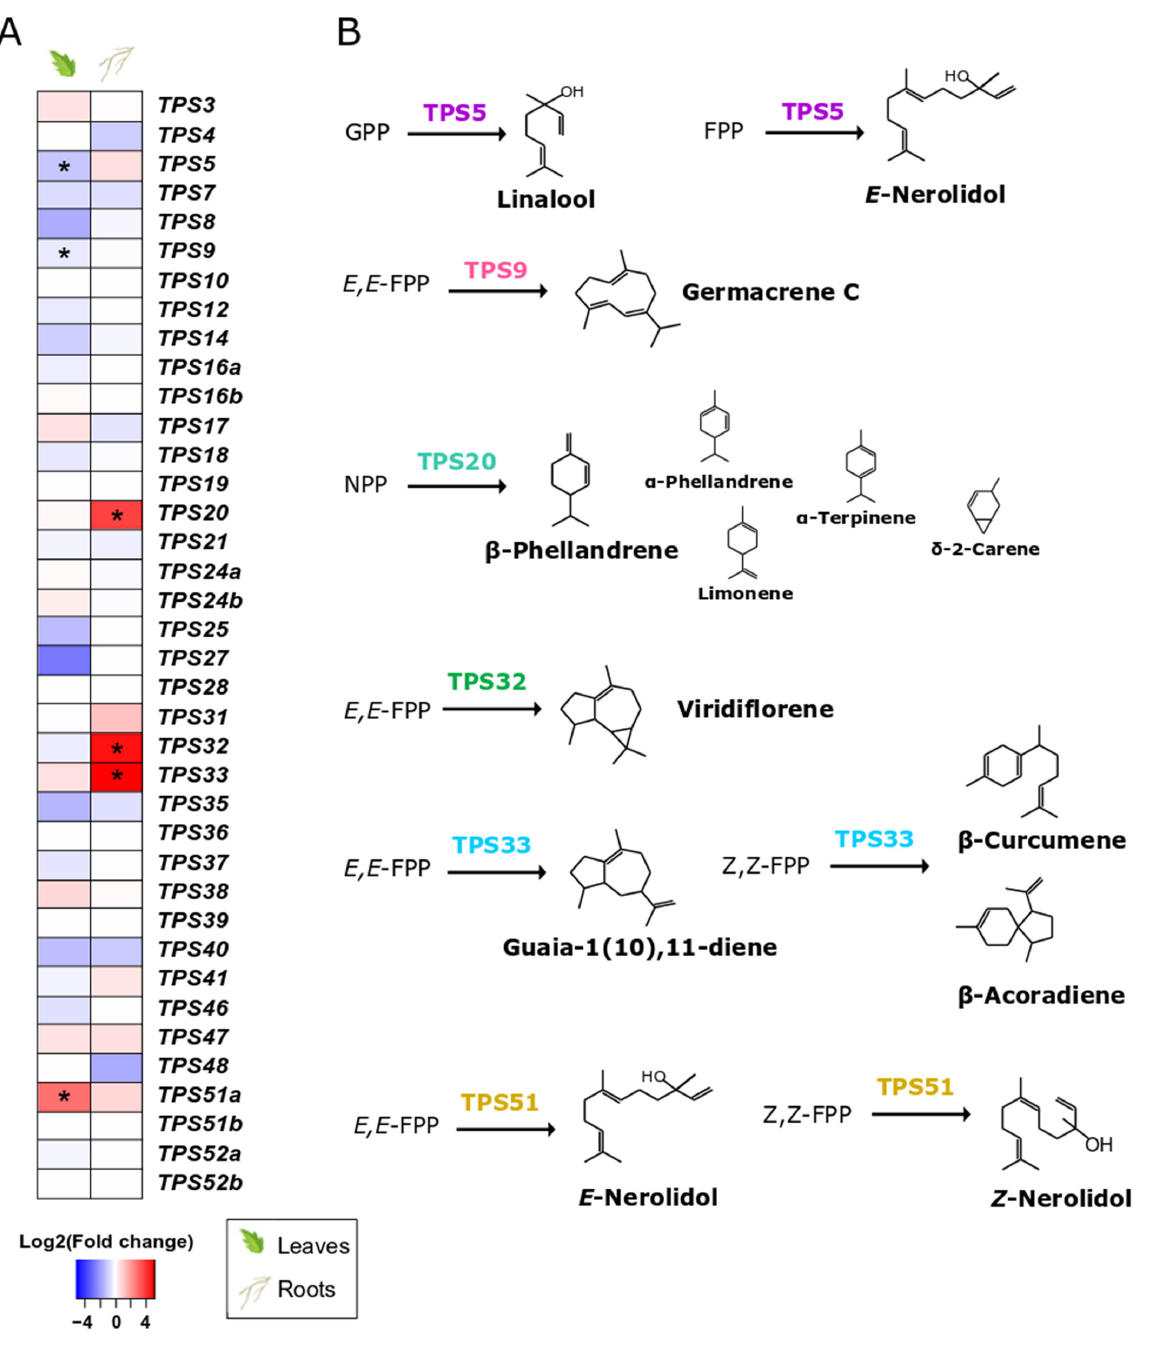
Figure 5. The tomato TPS family. ( A ). Effect of S. indica colonisation on the expression of tomato TPS s in leaves and roots. Changes in gene expression between tissues from inoculated plants and tissues from endophyte-free plants are represented as log2 of the fold change in the form of a heatmap. Data derived from RNA sequencing on leaves and roots from S. indica - and mock-inoculated plants. Asterisks (*) indicate FDR-corrected p ≤ 0.05, apart from TPS32 and TPS33 , whichwere expressed only in samples from inoculated roots, and no related transcripts were found in the samples of control roots. ( B ). Biosynthetic pathways catalysed by the TPSs, the expression of which is affected by S. indica colonisation, are only presented here. Main products of the enzymatic reactions are shown in regular font size, while terpenoids detected as minor peaks are shown in a smaller size. Reactions are drawn based on data from in vitro enzymatic assays from